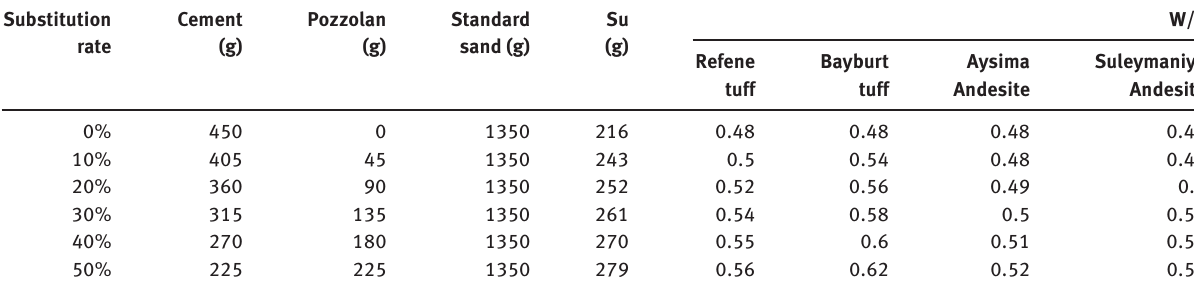
Table 7 According to ASTM C230 determined mortar samples water to cement (w/c) ratios.